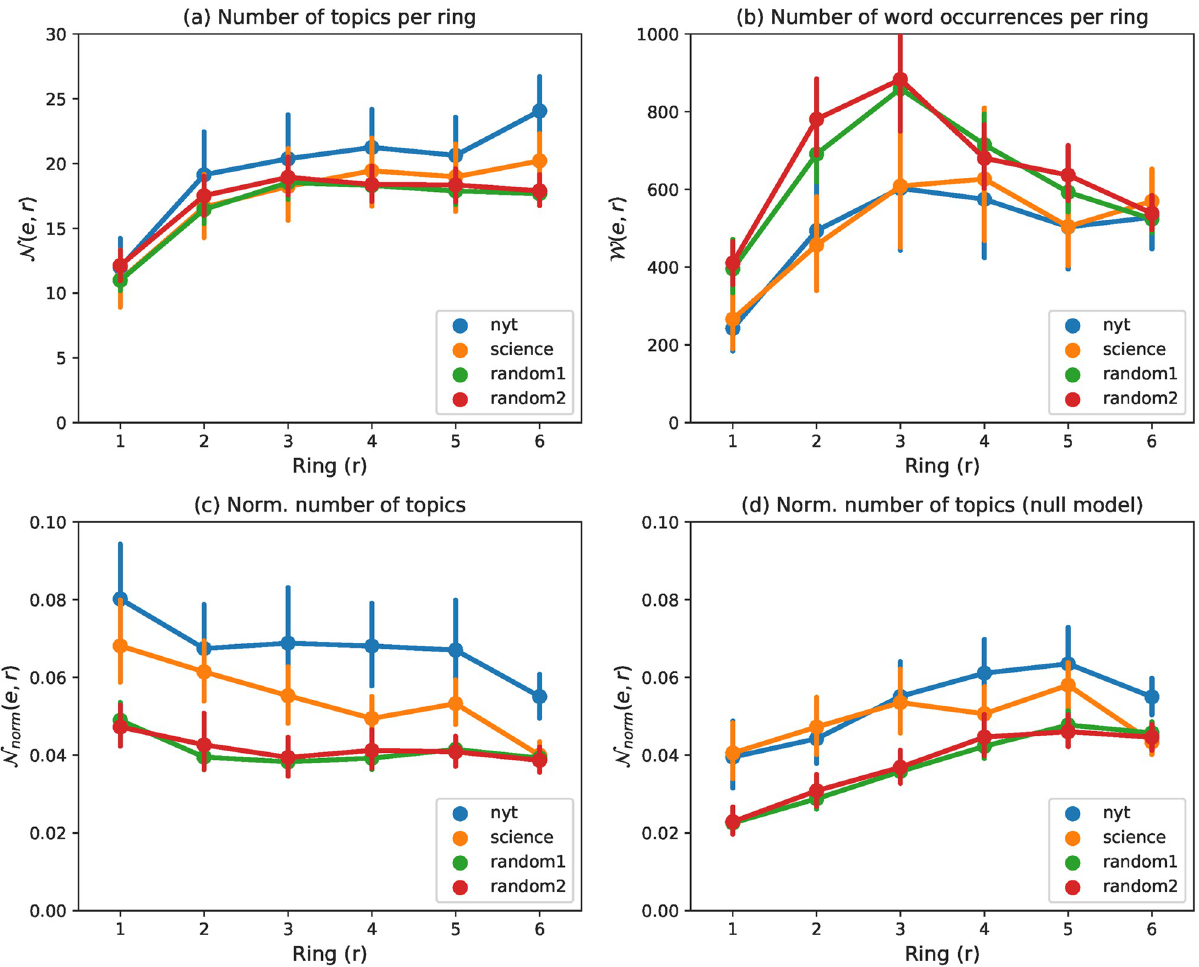
Fig 12. Average number of topics (a), number of word occurrences (b), and normalised number of topics (c) in each ring of the ego network. For “null” ego networks, we report only the normalised number of topics